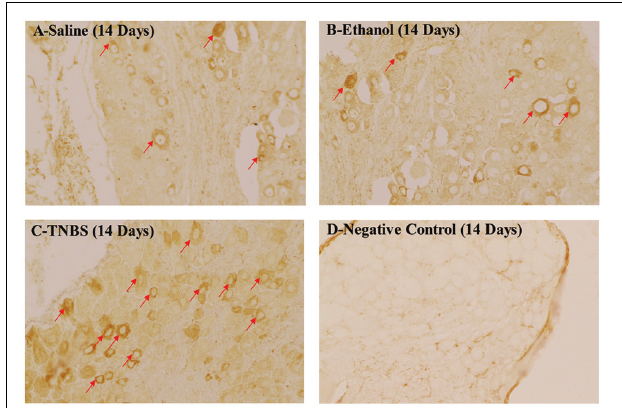
FIGURE 4 | Effects of TNBS administration on the expression levels of CGRP in the DRG of the rats. Densities of GRP-IR cells in the DRG at day 14 (A–C) . The negative control at day 14 (D) .